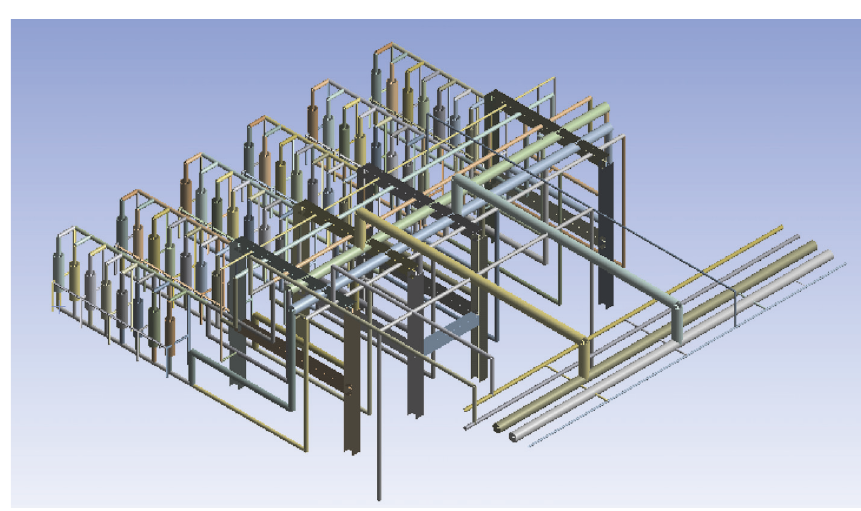
Figure 18: Additional constraints (2nd approach).